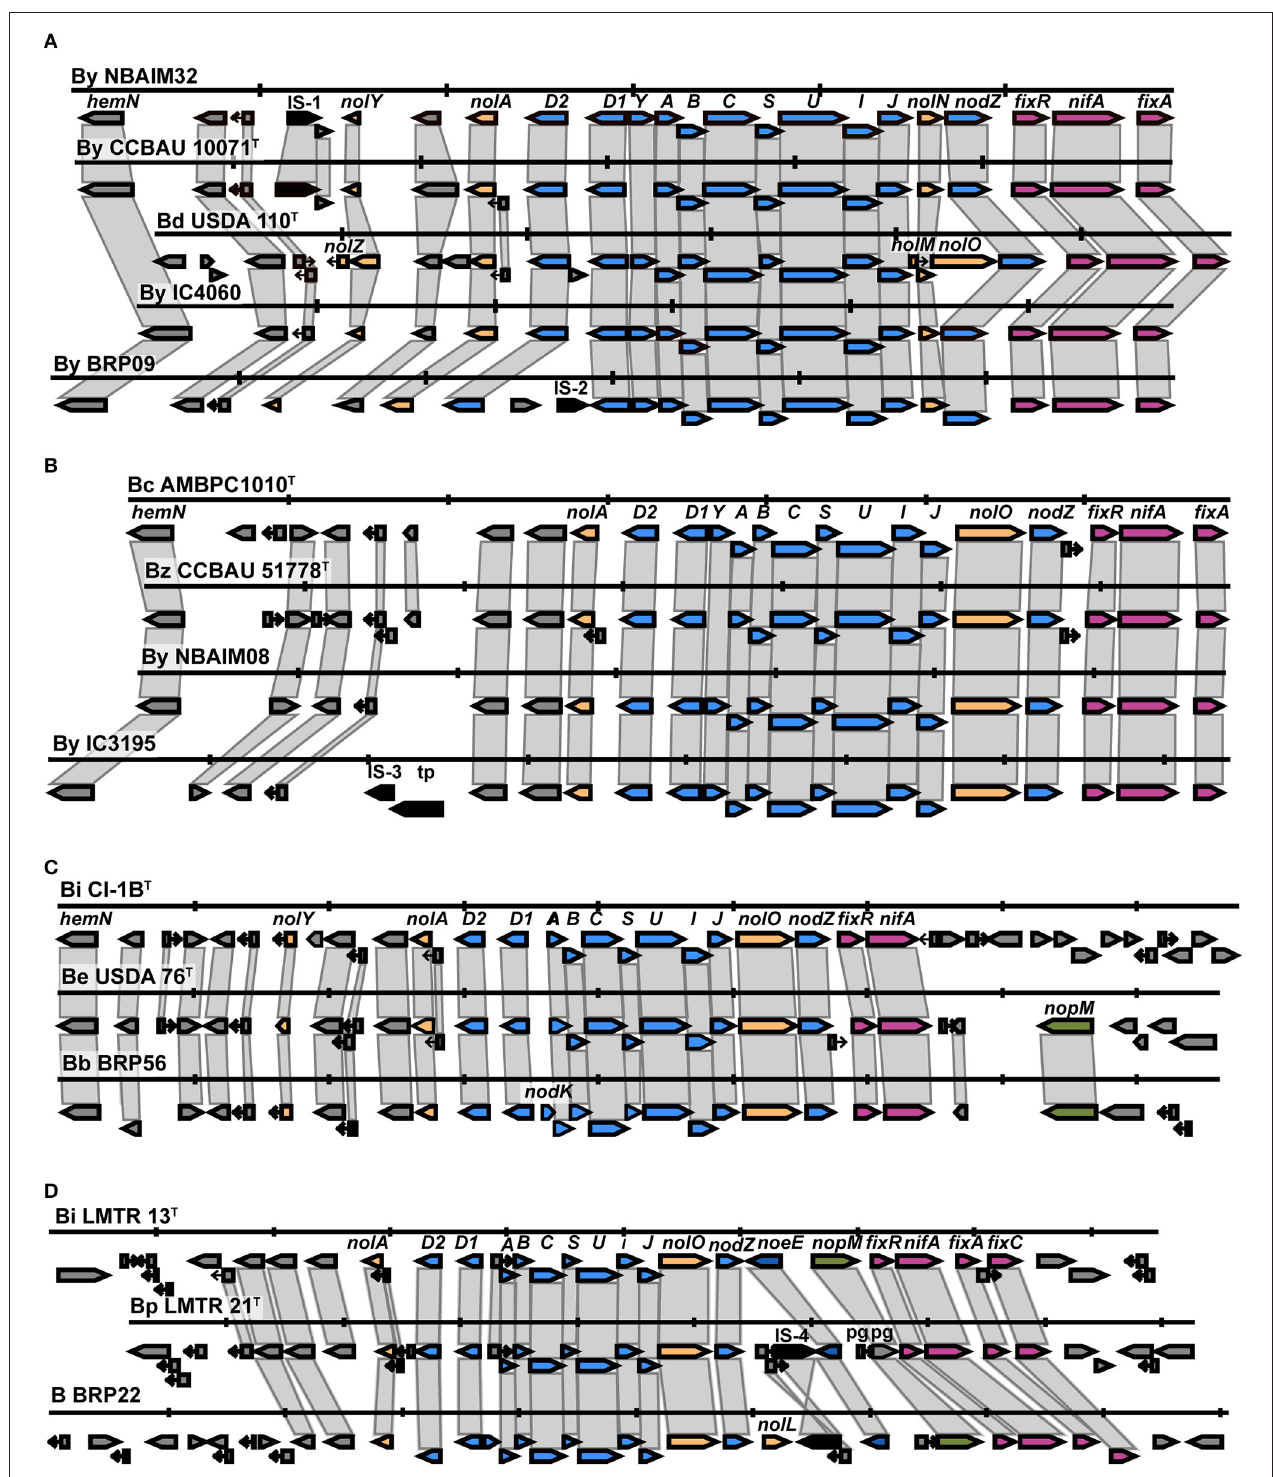
FIGURE 5 | The nod cluster synteny of IU and IC strains in the By, Bc, Be, and Bi groups. (A) By group, (B) Bc group, (C) Be group, and (D) Bi group. Each row represents a single strain and shows the nod cluster organisation and its genomic context. The colour of the arrow reflects the genes: blue for nod , yellow for nol , pink for fix-nif , green for nop, dark blue for noe , and black for transposase/insertion-related genes. Vertical markers indicate 5Kb in each genome. B ( Bradyrhizobium sp.), By ( B. yuanmingense ), Bd ( B. diazoefficiens ), Bc ( B. cajani ), Bz ( B. zhanjiangense ), Bi CI-1B T ( B. ivorense CI-1B T ), Be ( B. elkanii ), Bb ( B. brasilense ), Bi LMTR13 T ( B. icense LMT13 T ) and Bp ( B. paxllaeri